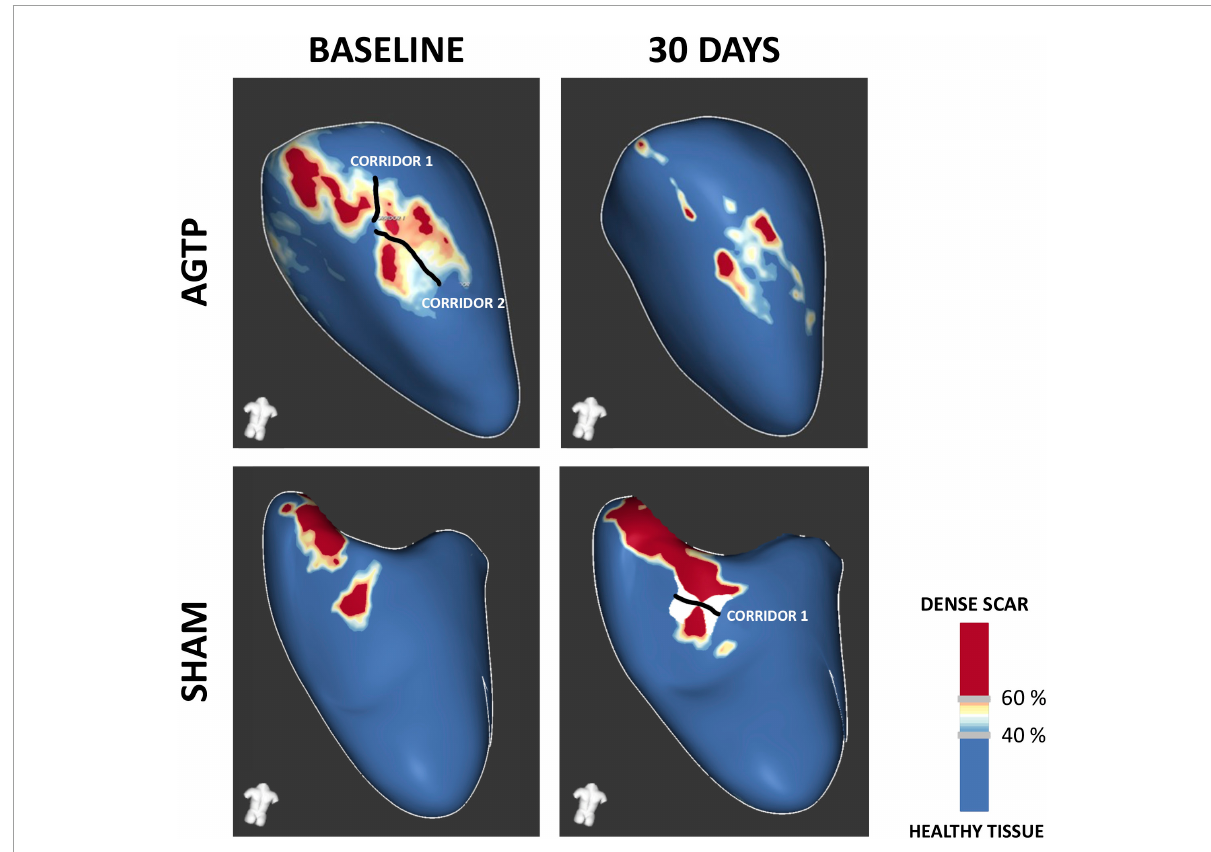
FIGURE2 Contrast-enhanced MRI-based tissue characterization. Representative examples of post-MI substrate remodeling at 30-day follow-up. Favorable remodeling was observed in the AGTP group (upper panel) , with a significant reduction in border zone (BZ) and dense scar and a trend toward reduced BZ corridors. Sham group (lower panel) showed increased scar volume and a trend toward development of new BZ corridors.